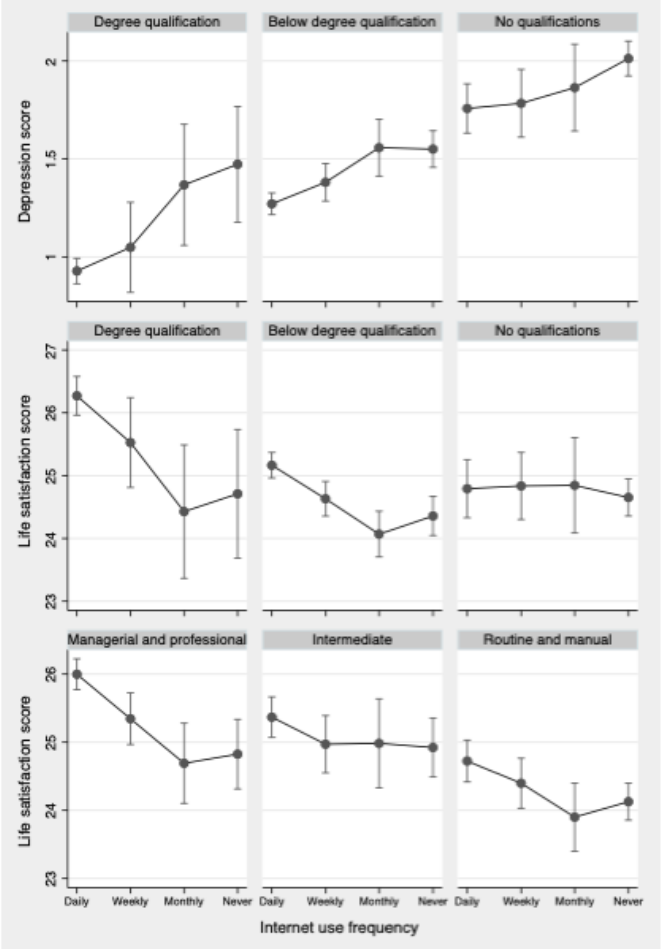
Figure 2. Predicted mental health score by socioeconomic position and frequency of internet usage from random effects model. Model adjusted for time-varying frequency of internet use, age, age square, working status, couple status, and health status and for time-invariant education, occupational class, wealth, and sex, including interaction terms for education and frequency of internet use and occupational class and frequency of internet